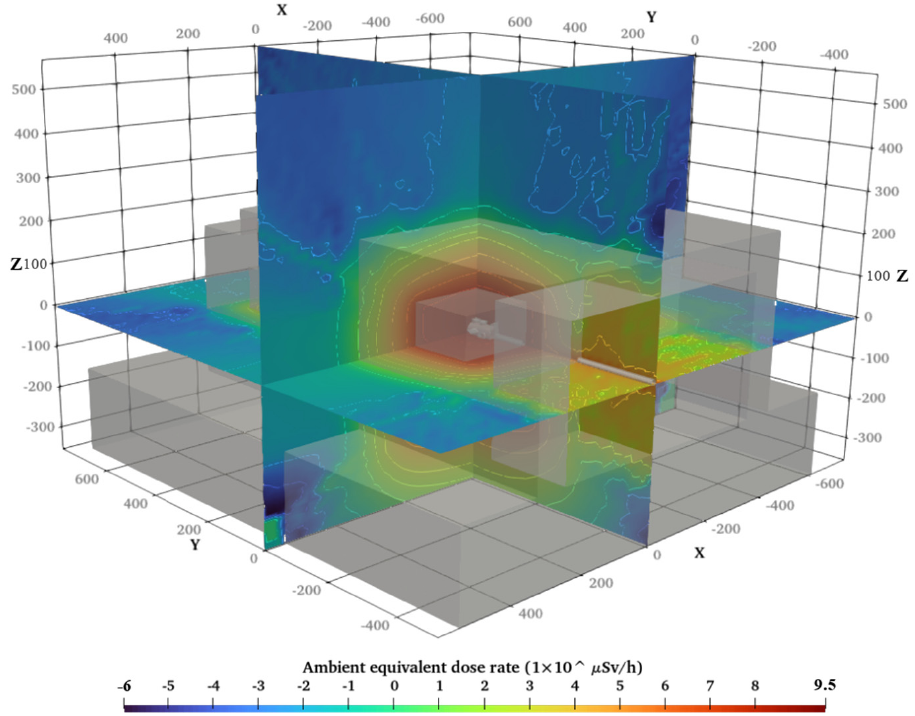
Figure 13. Visualization of FLUKA 3D radiation field simulation data based on ParaView.